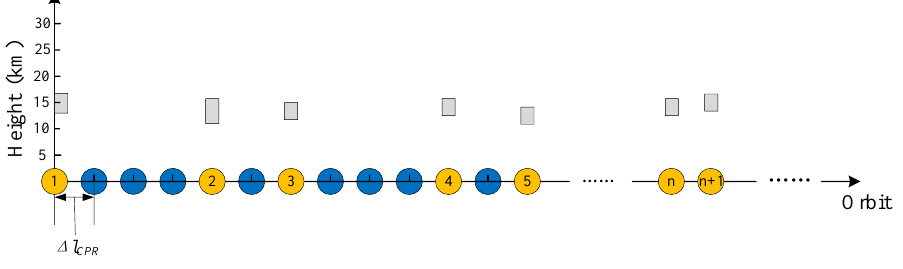
Figure 4 . Hypothetical distribution of CloudSat pixels of an arbitrary cloud type. Figure 4. Hypothetical distribution of CloudSat pixels of an arbitrary cloud type.